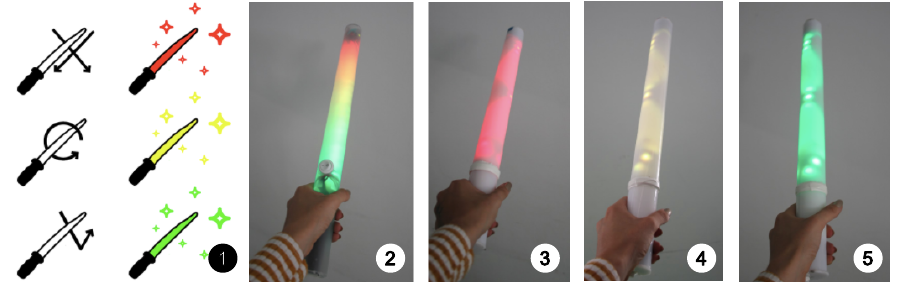
Figure 6. Glowing Wand technical prototype ( 1 . different hand gesture designs; 2 . switch for a rainbow feedback; 3 . negative tick gesture to red light; 4 . circle gesture to yellow light; 5 . tick gesture to green